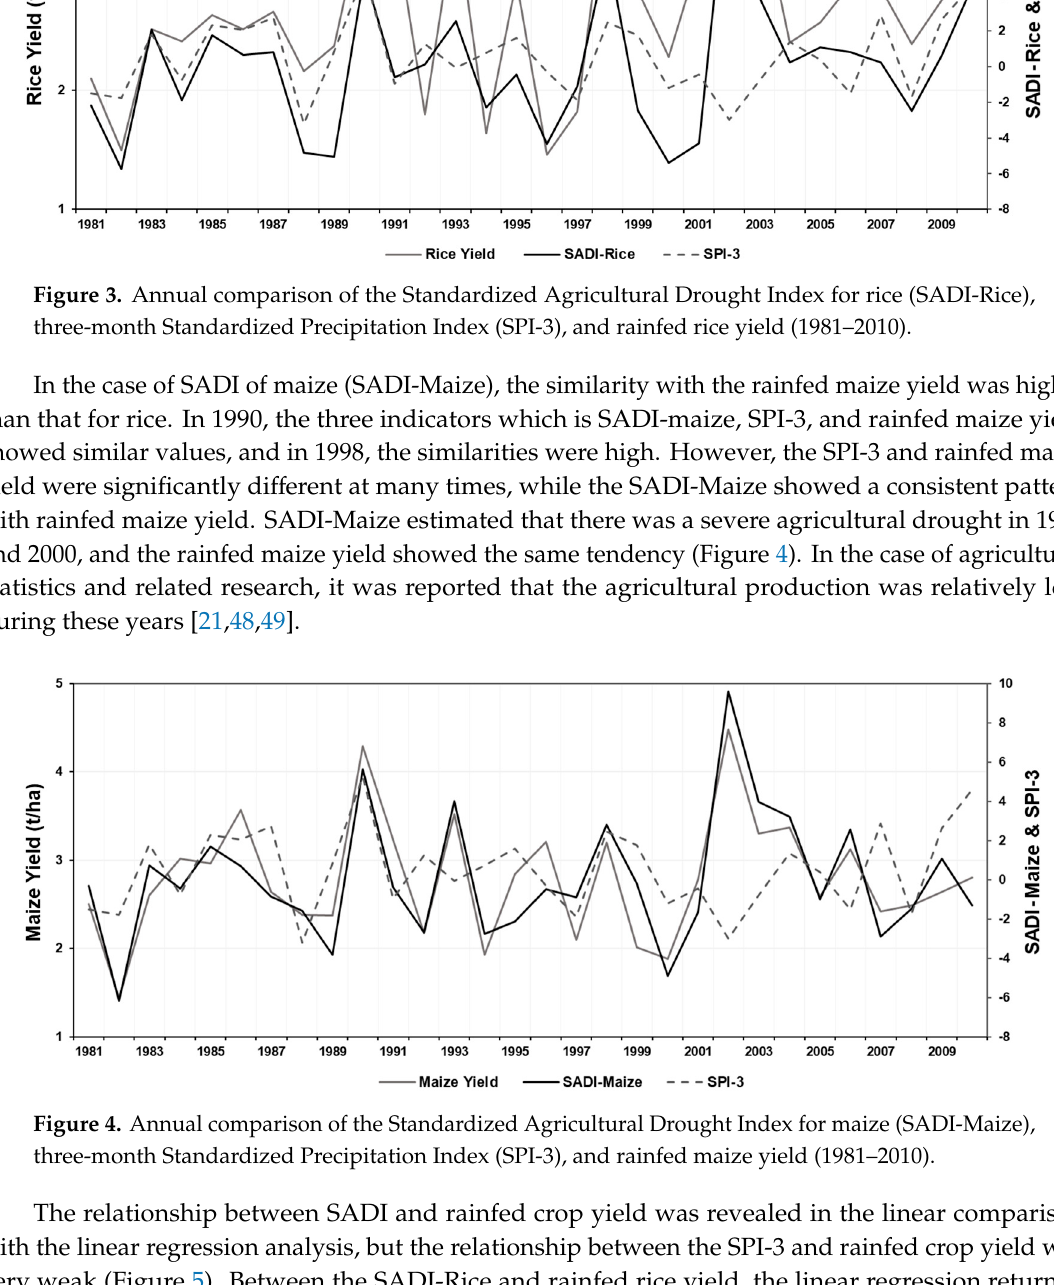
Figure 4. Annual comparison of the Standardized Agricultural Drought Index for maize (SADI-Maize), three-month Standardized Precipitation Index (SPI-3), and rainfed maize yield (1981–2010).